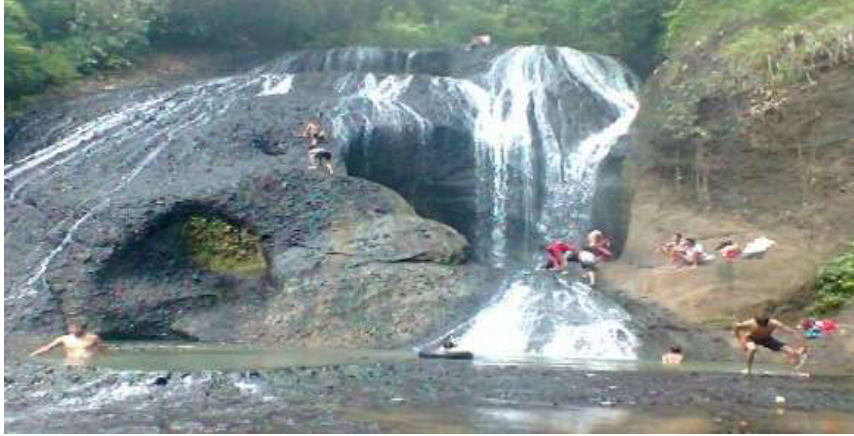
Figure 4. Bojong